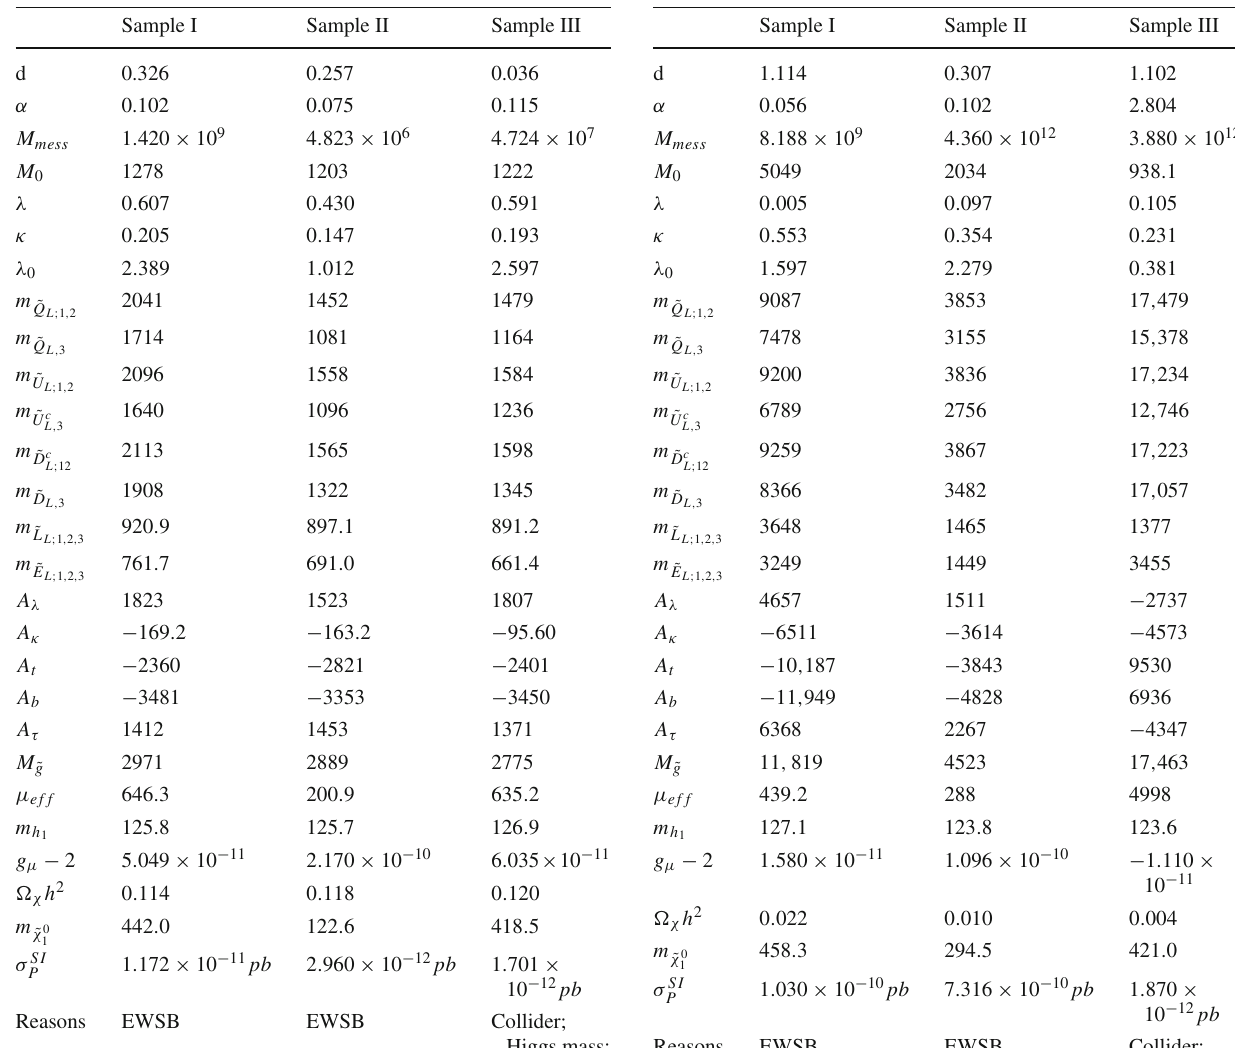
Table 2 Benchmark points, which should survive the various con- straints if the gauge-modulus interference contribution is absent. The quantities with mass dimension are in unit of GeV. With the gauge- modulus interference contribution, the points will not survive the con- straints because of the constraints shown in ‘ Reasons